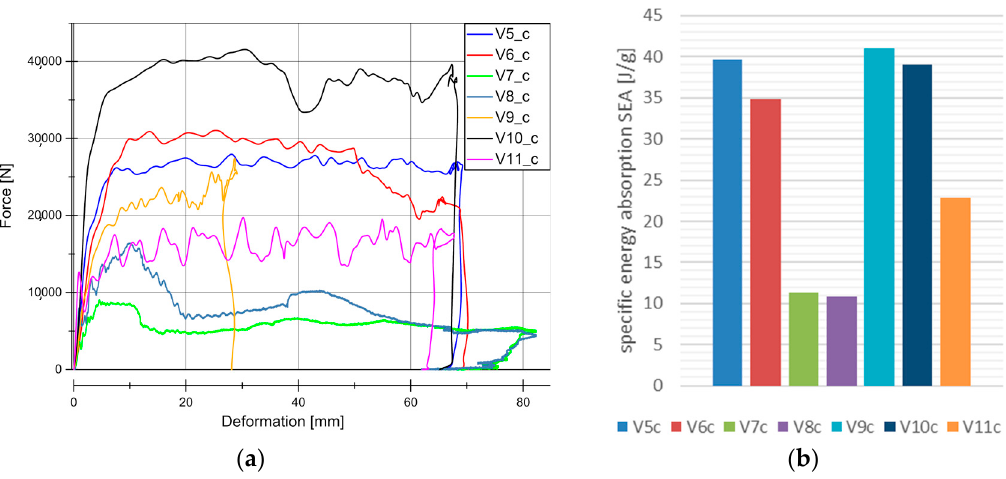
Figure 8. Results for dynamic experiments (series “c”). ( a ) Load-Deformation curve for all the material under dynamic conditions; ( b ) Specific Energy Absortion (SEA) for all of the material under dynamic conditions.